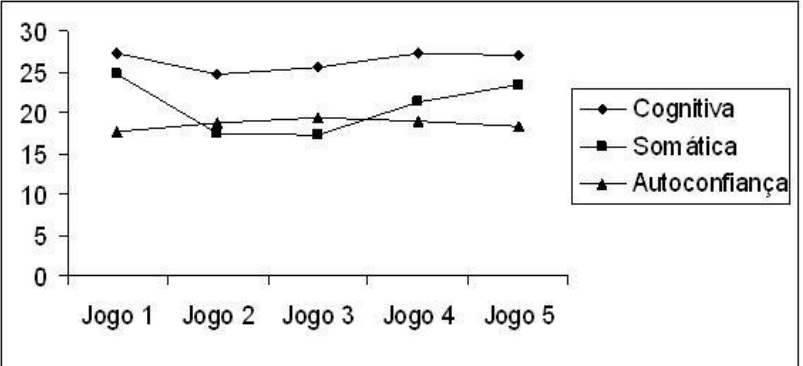
Figura 2. Índices da “ansiedade estado” na fase